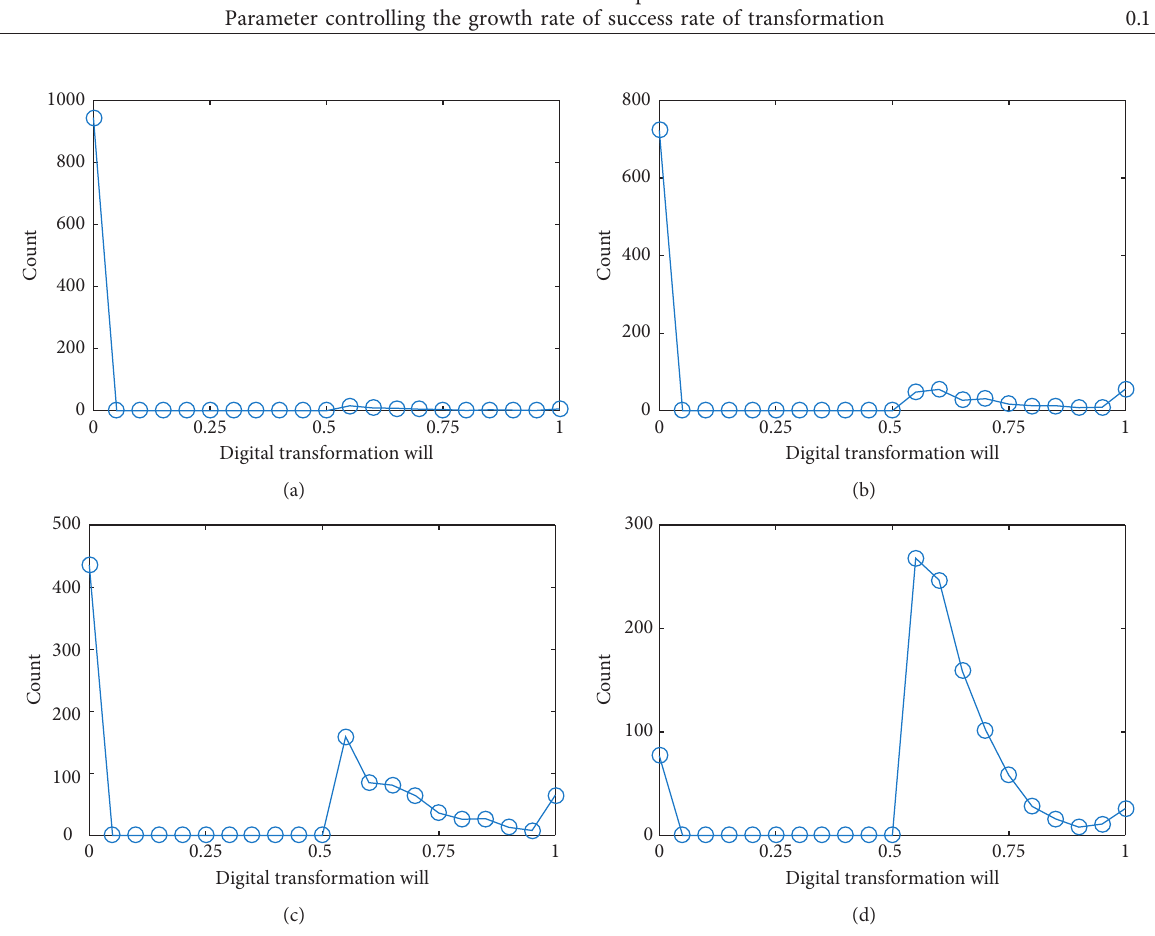
Figure 1: Enterprises’ willingness to transformation at different values of unit transformation cost: (a) Cu � 2, Cb � 4; (b) Cu � 1.5, Cb � 3; (c) Cu � 1, Cb � 2; (d) Cu � 0.5, Cb � 1.